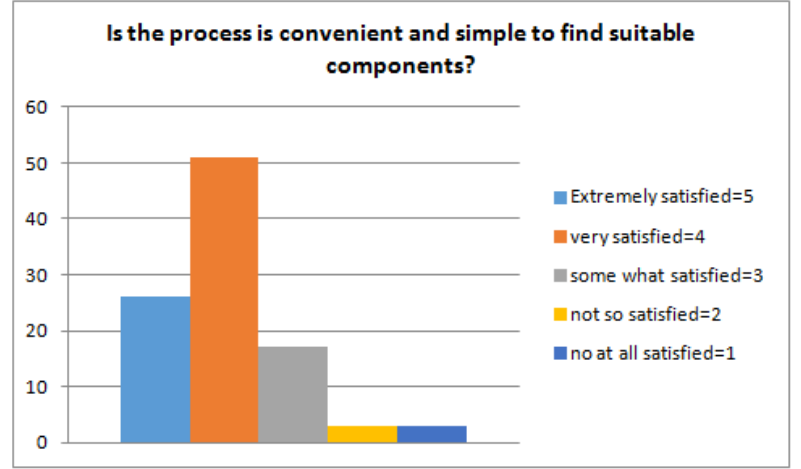
Figure 5. Process suitability to retrieve